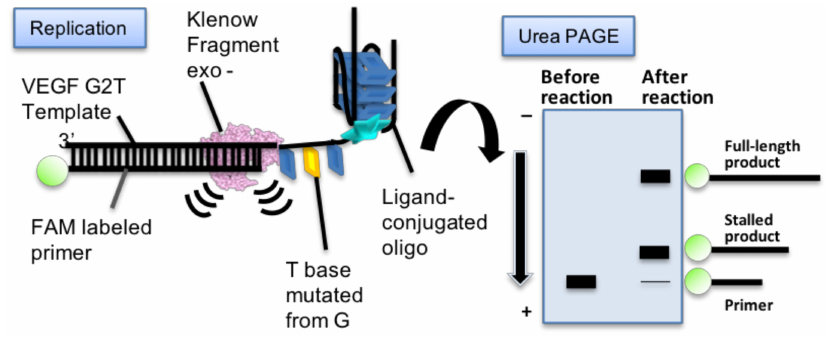
Figure 6. Schematic illustration of the replication